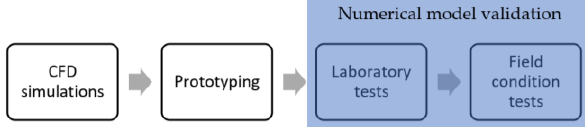
Fig. 3. Scheme of the research methodology Measurements in laboratory conditions were carried out at the Division of Automotive Engineering of Wrocław University of Science and Technology. A test stand was built, on which the supplied system was installed, consist- ing of a radiator with connecting wires, a circulating pump mounted between the buffer tank and the radiator (the cool- ant is sucked from the buffer tank and then pumped into the radiator), a flow meter mounted on the return wire from the radiator (in front of the buffer tank). A diagram of the stand is shown in Fig.